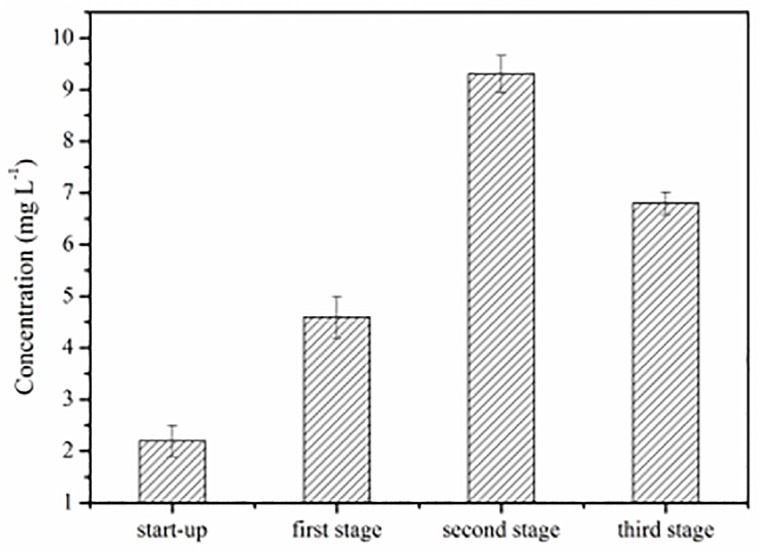
Concentrations of nitrite released.